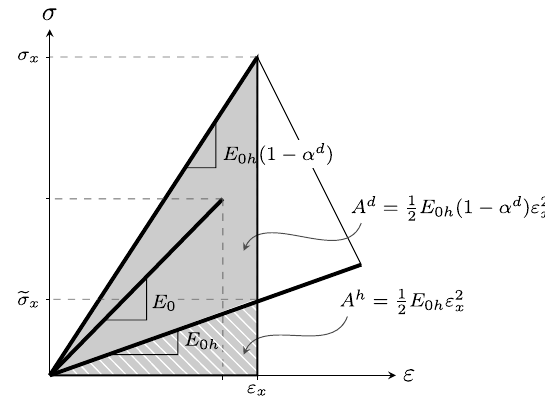
Fig. 2. Stress-strain diagram for the material at the stage of gain of stiffness.